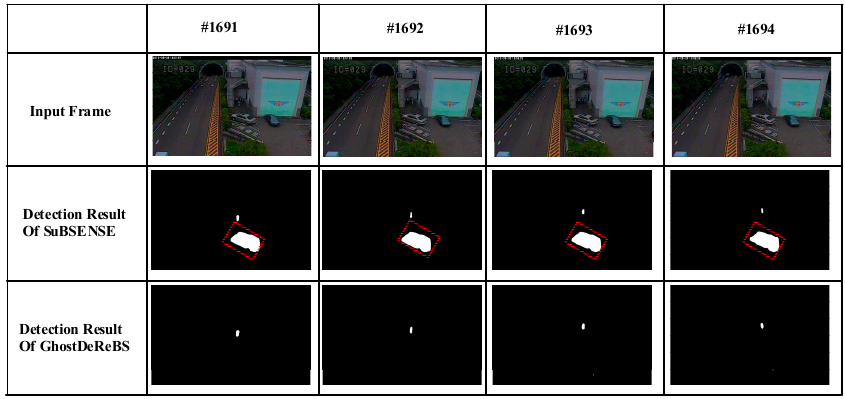
Figure 5. Detection result comparison of SuBSENSE and GhostDeReBS.